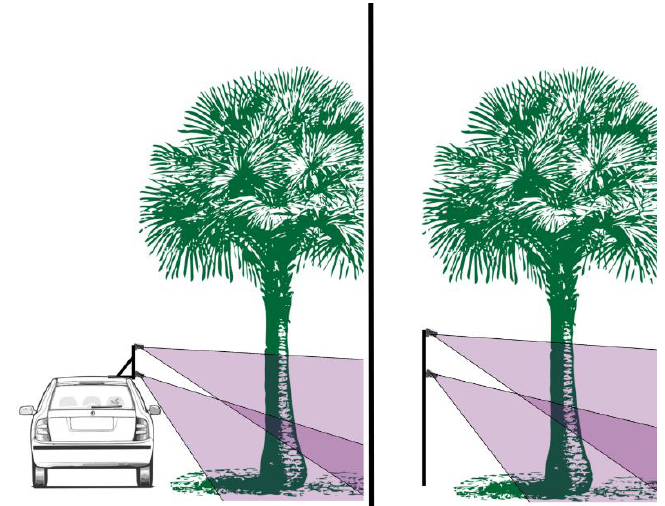
Figure 1. Schematic of the experimental stereoscopic mobile camera set-up. Representation of image capture with a mobile vehicle ( left ) and stationary image capture with a surveying pole ( right ).